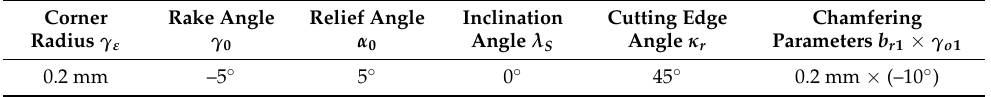
Table 4. Geometrical parameters of the cutting